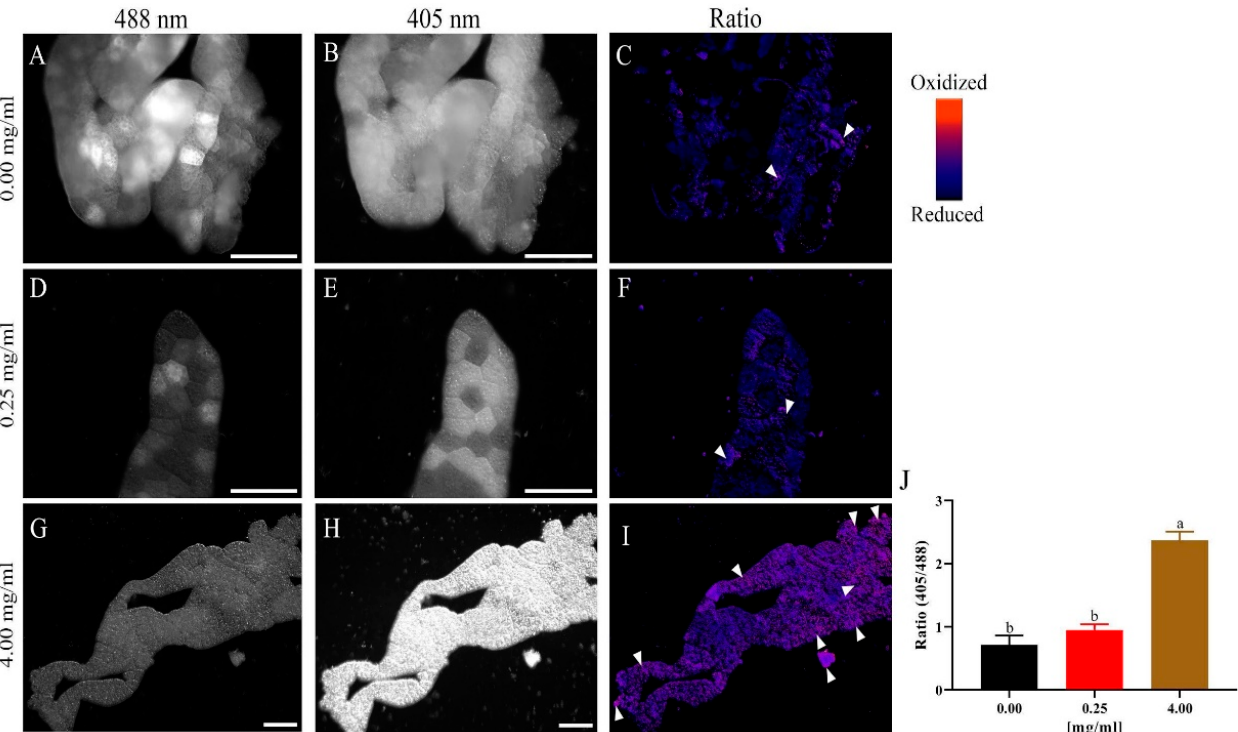
Figure 7. Larval exposure to Eu 3+ -doped TiO 2 leads to higher levels of tissue oxidation. Representa- tive images of the fat body of L3 larvae expressing the hydrogen peroxide-sensitive mitochondrial probe mito-roGFP2-Orp1, ppl-GAL4>UAS-mito-roGFP2-Orp1 ( n = 5 per group). ( A – C ): representative images of the fat body of animals exposed to the control medium. In ( A ), the reduction channel (488 nm) for roGFP2 is observed. In ( B ), the oxidation channel (405 nm) is observed for the same probe. In ( C ), the ratiometric image (405 nm/488 nm) of the same acquisition is shown. ( D – F ): Representative images of the fat body of animals exposed to 0.25 mg/mL of Eu 3+ -doped TiO 2 , with ( D , E ) showing the reduction and oxidation channels, respectively. In ( F ) the ratiometric image (405 nm/488 nm) is formed by images ( D , E ). ( G – I ): Representative images of the fat body of animals exposed to 4 mg/mL of Eu 3+ -doped TiO 2 , in which we can clearly observe the increase in oxidation ( H , J ). Scale bars = 150 μ m.